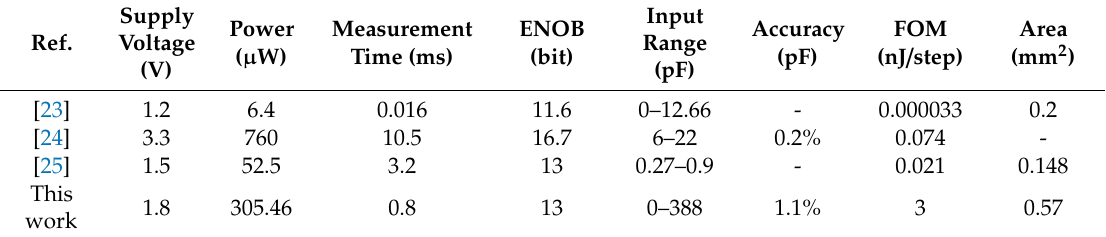
ENOB—e ff ective number of bits; FOM—figure of merit.